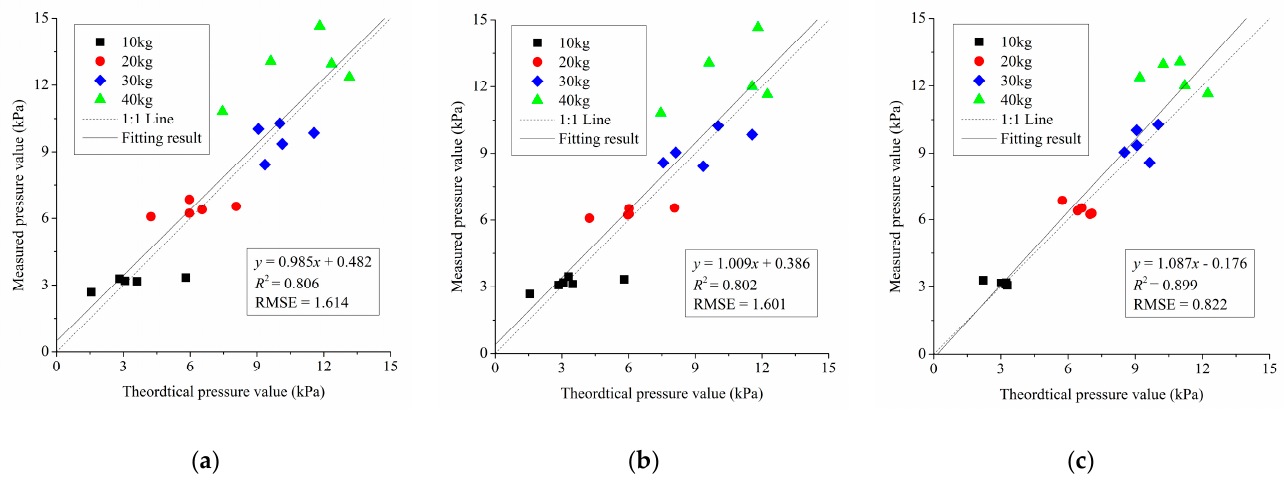
Figure 16. Comparison between theoretical and measured pressure values. ( a ) Soil water content of 10%; ( b ) Bulk density of 2 mg·m − 3 ; ( c ) Slope Angle of 10°.